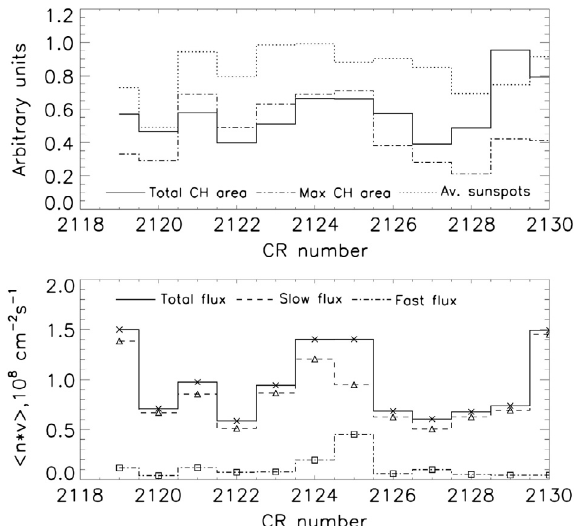
Figure 7. Top panel: variations of the CH areas during CR 2119– 2130 (January–November 2012) in arbitrary units. Solid line – the total CH area; dashed-dotted line – the maximum value of the CH area in the current rotation obtained from the SDO/AIA images at 193 A˚ . Dotted line – the daily sunspots numbers averaged over each rotation (in arbitrary units). Bottom panel: variation of the SW density flux during CR 2119–2130. Solid line with crosses – the total SW density flux; dashed line with triangles – the slow SW density flux ( V < 450 km s (cid:2) 1 ); dashed-dotted line with squares – the fast SW density flux ( V > 450 km s (cid:2) 1